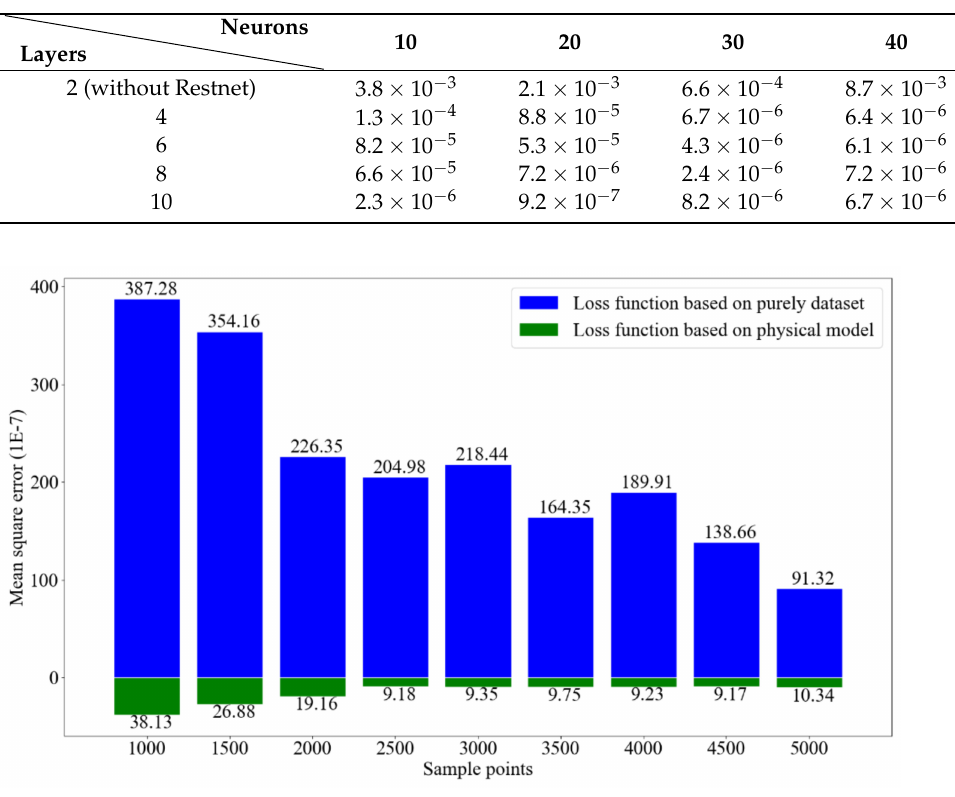
Figure 5. The comparisons between mean square error of velocity calculated by loss function based on purely dataset and that calculated by loss function based on physical